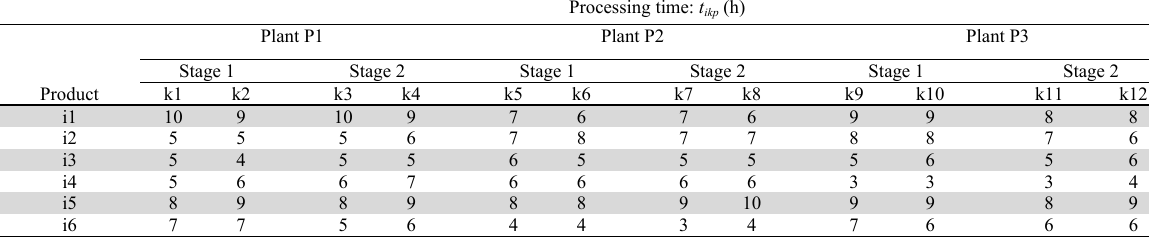
Processing times of orders for Example 2